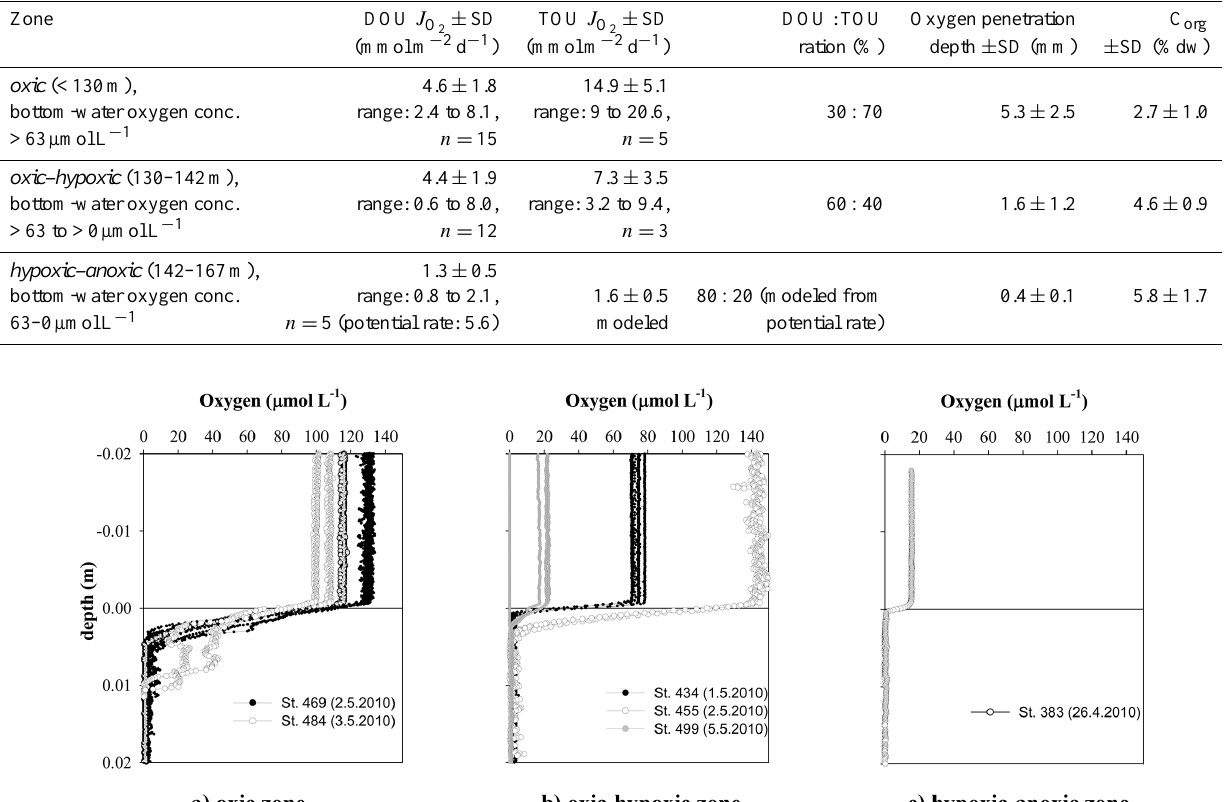
zone, concentrations of dissolved iron were reduced